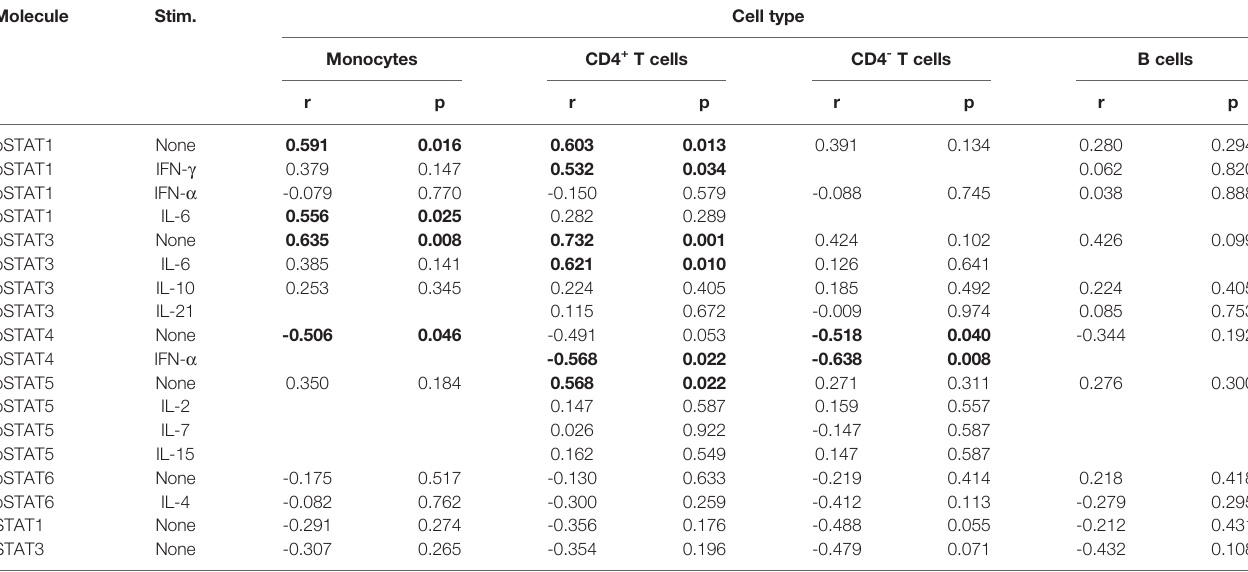
TABLE 4 | Correlation of baseline pSTAT levels and total STAT1 and STAT3 expression levels with improvement in DAS28 during 3-month treatment with tofacitinib and csDMARDs. Molecule Stim.